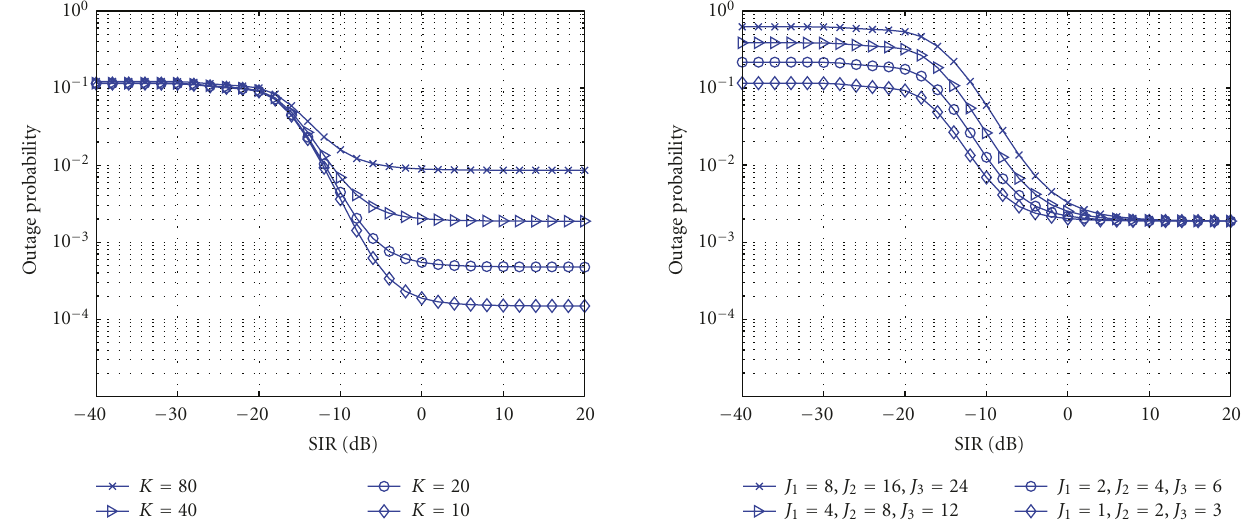
Figure 6: Outage probability of a DS/FH system; Impact of the number of users, the number of antenna elements M = 2, processing gain G DS = 50, the number of interferers is J 1 = 1, J 2 = 2, J 3 = 3, duty cycles of interferes are ρ 1 = ρ 2 = ρ 3 = 0 . 2, SNR Γ N = 100 dB, the number of hopping channels N = 10, the number of multiple path L = 3, decay factor δ = 0, and protection ratio r th = 3dB.